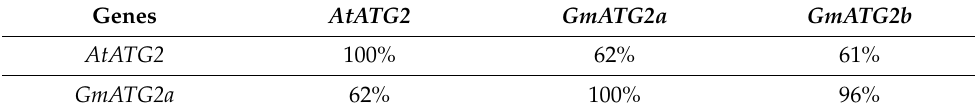
Table 1. Homology shared between Arabidopsis and soybean ATG2 genes.